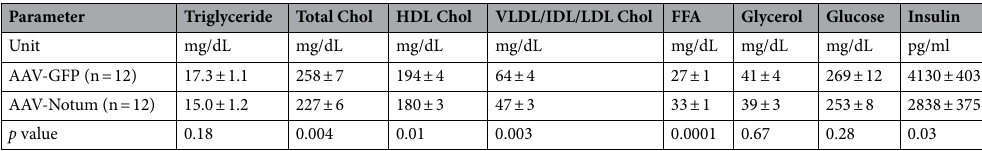
Table 1. Plasma lipids, lipoproteins, glucose, and insulin levels of mice that received AAV-GFP or AAV- Notum and fed a HF/HS diet for 14 weeks. Values shown are means ± standard errors. Chol. Cholesterol, FFA Free fatty acids.